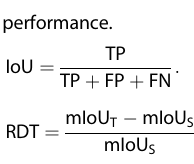
Fig. 7 Simpli fi ed schematic representation of AdaptSegNet 7 . Tile examples from the source and target 2 domains are given on the left. The source prediction is used in a supervised manner with cross-entropy loss. Both domains' prediction are fed into the